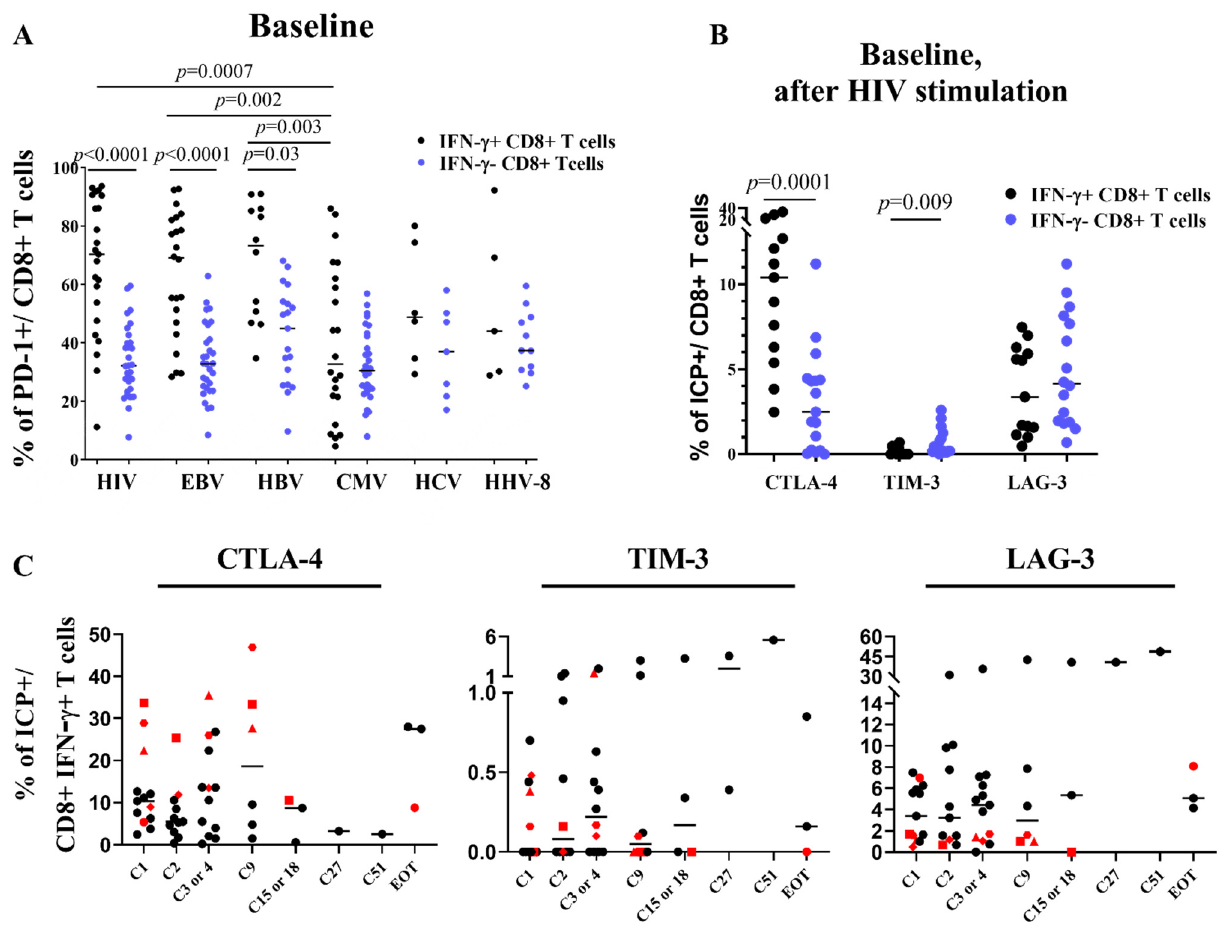
Figure 5. In PLWH with cancer, high levels of ICP expression are detected on HIV-specific T cells, without upregulation on anti-PD-1 therapy. Thawed PBMC were stimulated during 6 h with viral peptides and then stained with intra-cellular anti-cytokine antibodies (anti-IFN- γ , anti-IL-2 and anti-TNF- α ). HIV-specific CD8 + T cells were defined as IFN- γ producing CD8+ T cells after HIV stimulation. ( A ), PD-1 expression among specific (black spots) and non-specific (blue square) CD8 + T cells at baseline depending on viral stimulations. Mann Whitney test. ( B ), CTLA-4, TIM-3 and LAG-3 expression among HIV-specific and non-specific CD8 + T cells after HIV stimulation ( n = 18). Mann Whitney test. ( C ), expression of CTLA-4 (left), TIM-3 (middle) and LAG-3 (right) on HIV specific CD8 + T cells overtime. Red spots denote the patients with reservoir reduction. EOT: end of treatment. At cycle 1, n = 32; at cycle 2, n =29; at cycle 3 or 4, n = 29; at cycle 9, n = 11; at cycle 15, n =5; at cycle 27, n = 3; at cycle 51, n = 1; at end of treatment, n = 5. Experiments were monoplicates.